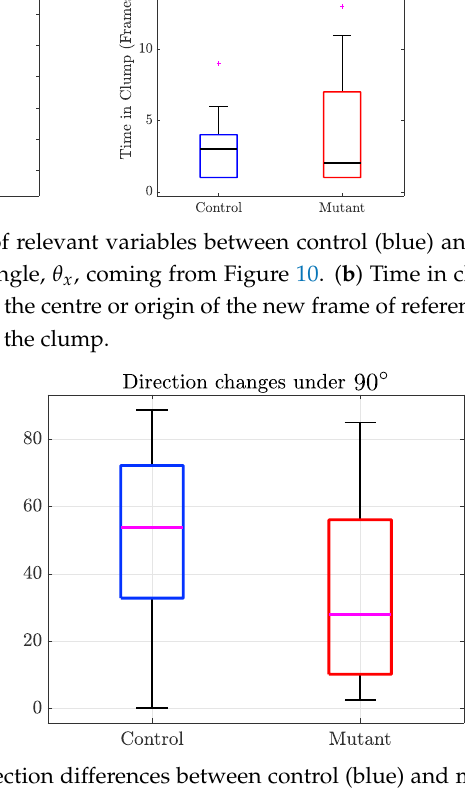
Figure 12. Change of direction differences between control (blue) and mutant (red) interactions for those tracks whose absolute value of the angle is in the range 0 ◦ < θ x < 90 ◦ . These two populations present a statistical significant difference ( p = 0.03)